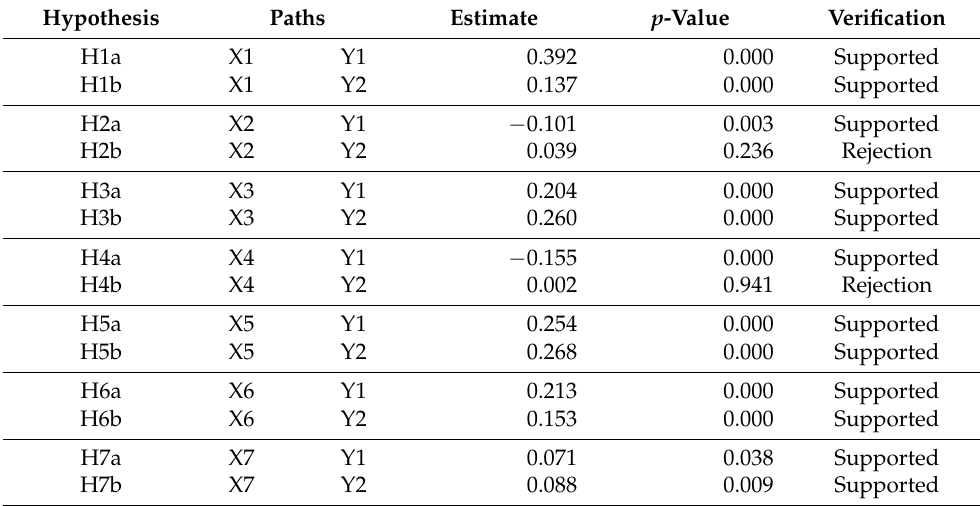
Table 4. Verification of research